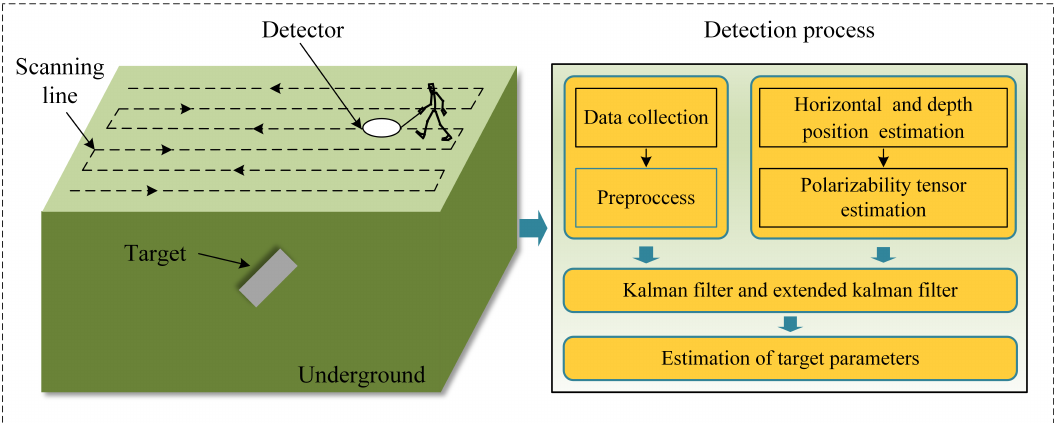
Figure 1. Process of the metal detection